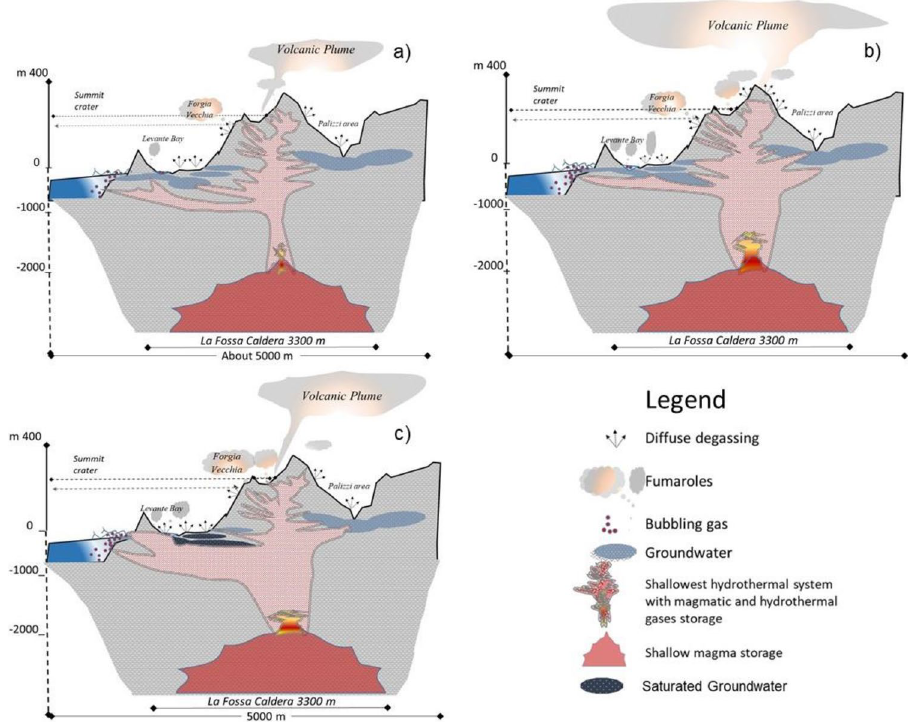
Figure 8. Sketch map of Vulcano plumbing system of NW–NE profile of the Caldera La Fossa running from Mt. Lentia, Vulcano Piano. The ratio between height and length of this profile is H/L = 1.5; the total length is 4.6 km; and La Fossa Caldera occupies 3.3 km along this section. The schematic sections show: ( a ) the background condition of solphataric release (modified from Inguaggiato et al. 13 ); ( b ) a starting anomalous deep input that influenced the fluid release at summit area of the active cone and at the Palizzi area. (June–December 2021); ( c ) the volatiles wave propagation arrived at the Levante Bay area (January–May 2022), when the deep input of mass and energy modified the buffer and scrubbing property of the underling hydrothermal system triggering the maximum CO 2 output ever recorded. The maps were created using Microsoft ® PowerPOint ® 2016 (16.0.4266.1001) MSO (16.0.5365.1000). (https:// www. micro soft. com/ it- it/ micro soft- 365/ previ ous- versi ons/ micro soft- office-